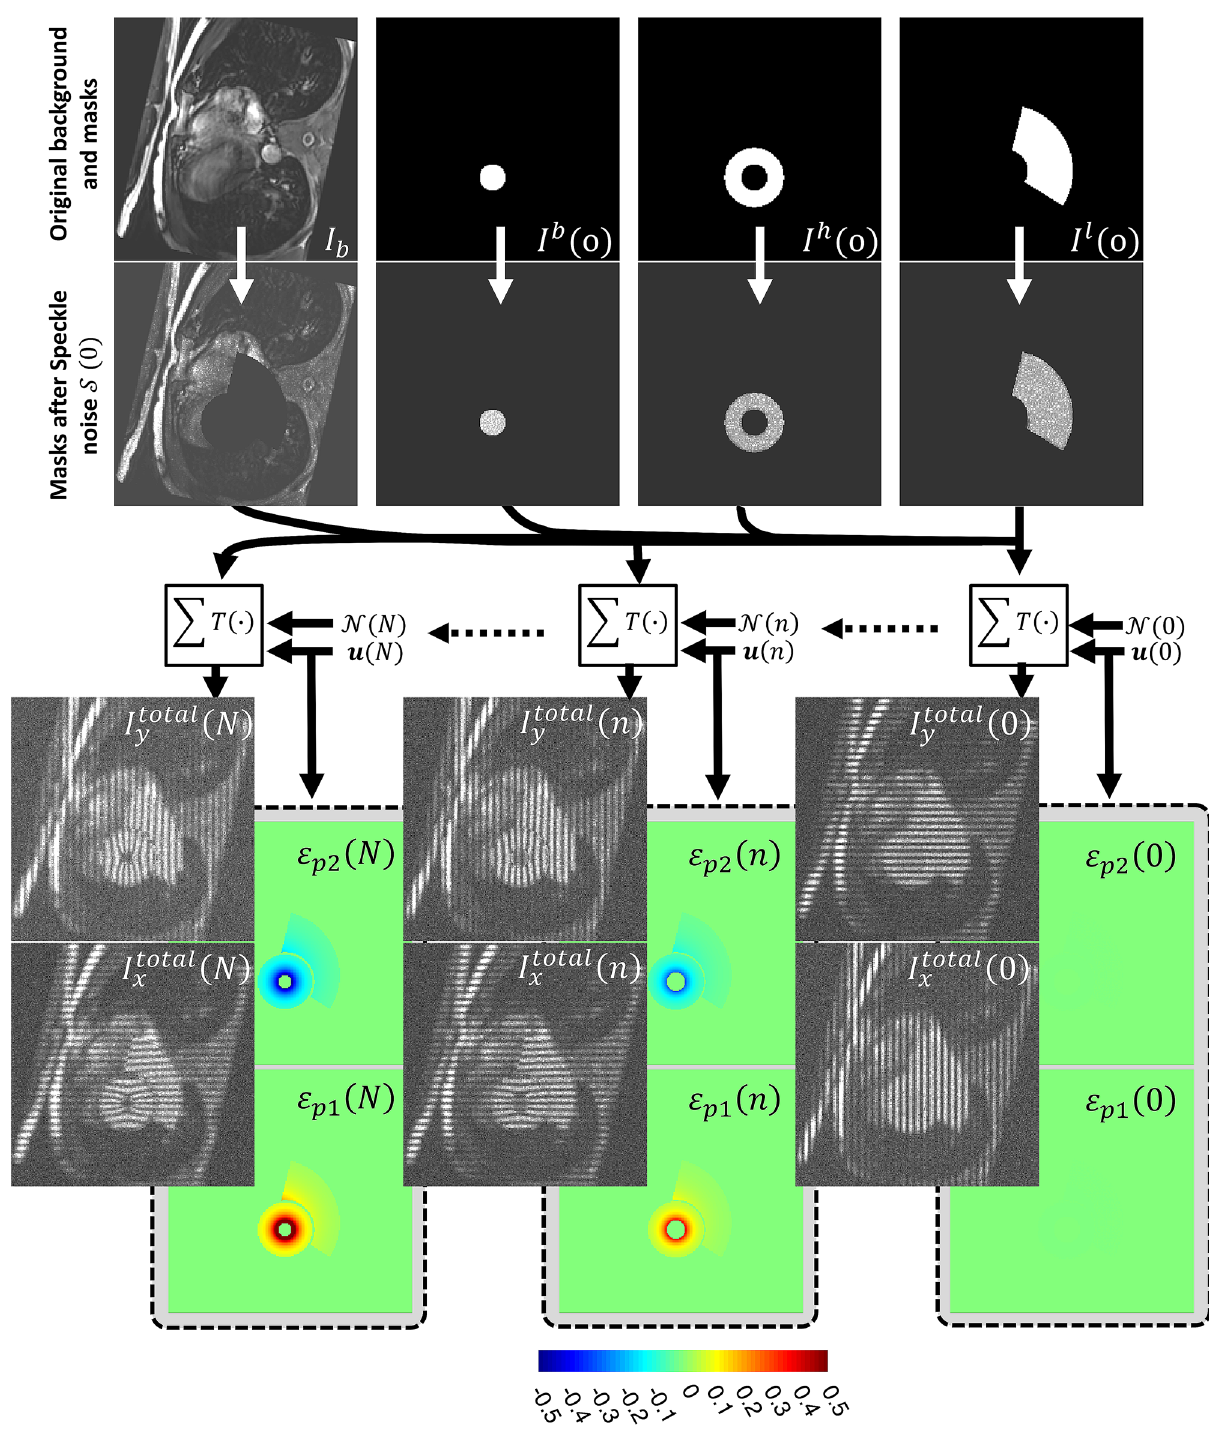
Figure 12. Steps of generating simulated tagging cine. A background image I b is randomly chosen from the pool of previously acquired MRI images. The anatomical and imaging parameters are then chosen from their corresponding pools. Regions of the Liver I l , heart I h , and blood I b are generated for all time frames following the planned anatomical and functional settings. The corresponding ground-truth strain maps ε p 1 and ε p 2 in the liver and heart are generated. Speckle pattern S is superimposed on the combined image. Displacement maps u are then generated and used to create the corresponding tagging pattern for each time frame. Final images I total y and I total x are created after the multiplication of the tagging pattern and the speckled image and adding the white